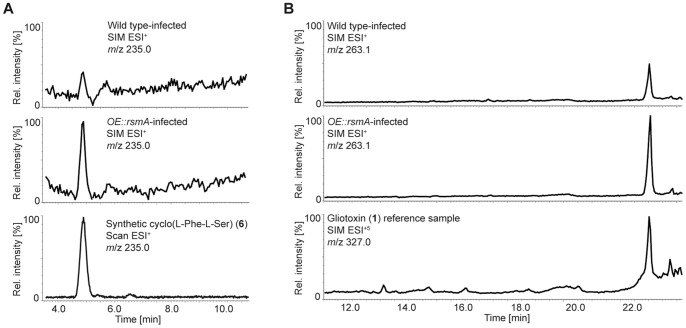
Infected mouse lung extracts (IMLE) HPLC- single ion monitoring (SIM)MS ion chromatograms.HPLC-SIMMS analysis of crude mouse lung extracts corresponding to mice infected with wild type, or OErsmA. (A) Ion chromatogram showing compound 6 is approximately two to three times as abundant in the OErsmA-IMLE relative to WT-IMLE. (B) Similarly, gliotoxin is about two times as abundant in OErsmA-IMLE than WT-IMLE. Reference chromatograms (bottom panels) show diagnostic ions of cyclo(L-Phe-L-Ser) (6) and gliotoxin (1). Lung extract chromatograms are scaled to the peaks measured in the OErsmA-IMLE sample (bottom panels of standards are not to scale).